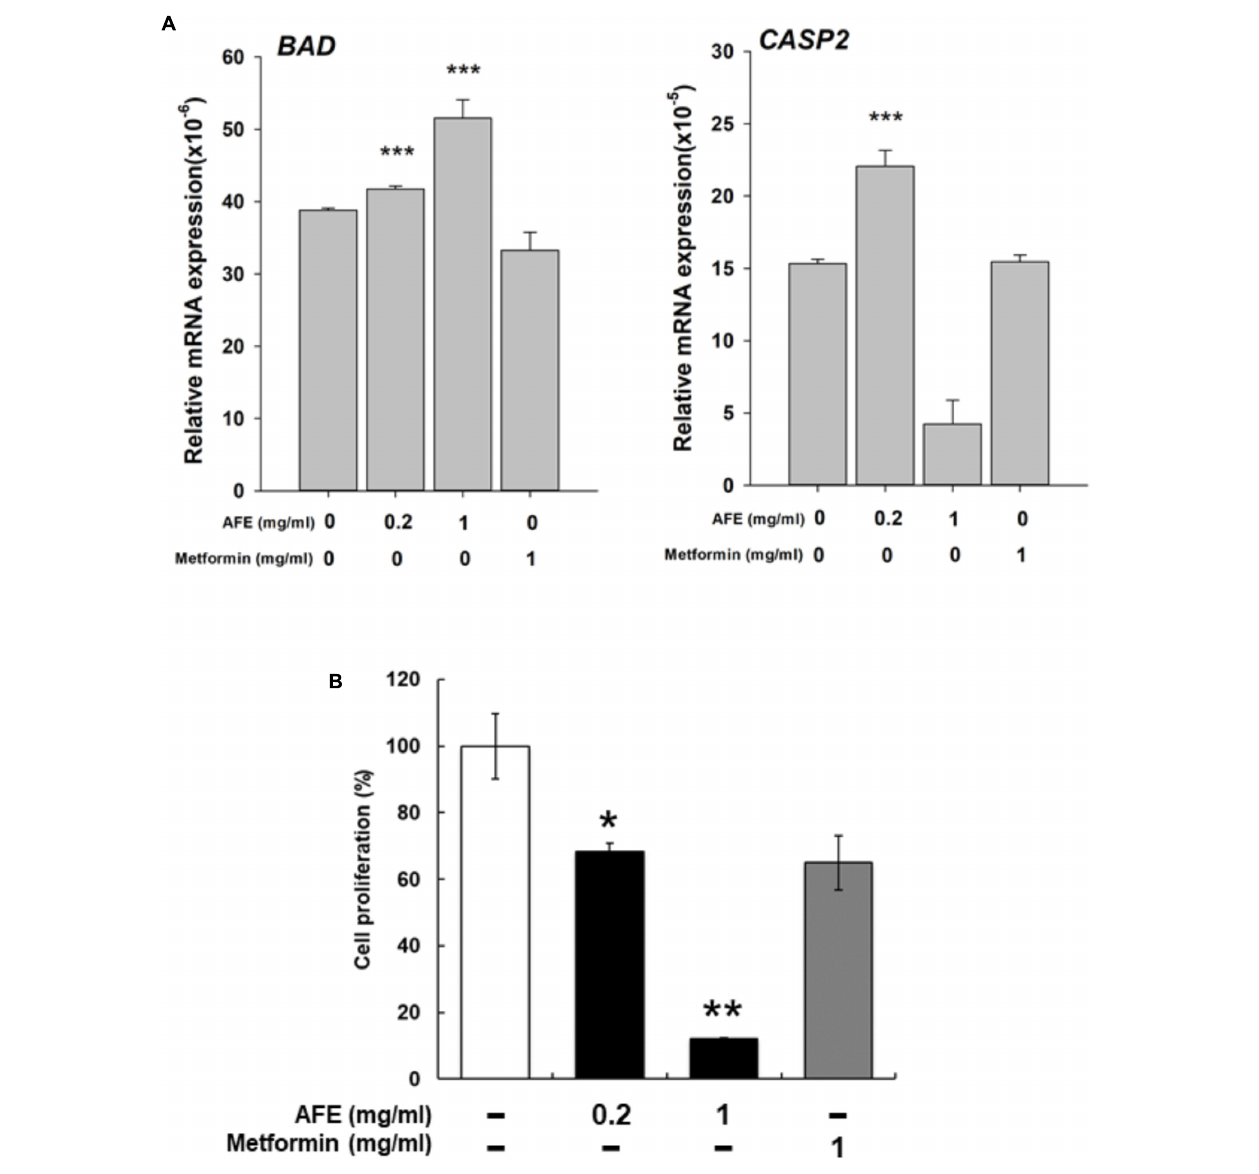
FIGURE 6 | Anoectochilus formosanus extract regulates expression of anti-proliferative genes and cell proliferation in oral cancer SCC25 cells. SCC-25 cells were treated with different concentrations of AFE or metformin with refreshed media with agents daily for 3 days. (A) Total RNA was extracted and qPCR was performed for BAD and CAPS2 . n = 3 ∗∗∗ p < 0.001 as compared with control. (B) SCC-25 cells were treated with AFE (0.2 and 1 mg/ml) or metformin (1 mg/ml) with refreshed media with agents daily for 3 days. AFE induced anti-proliferation. –: treated with normal saline as control; n = 3 ∗ p < 0.05, ∗∗ p < 0.01 as compared with